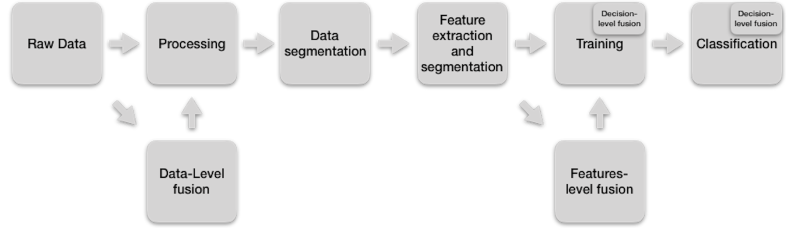
Figure 3. Extended activity recognition workflow.